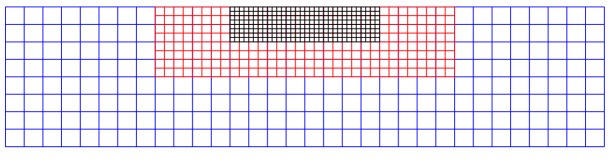
Schematic view of a nested finite difference grid for the agar region Ω2.